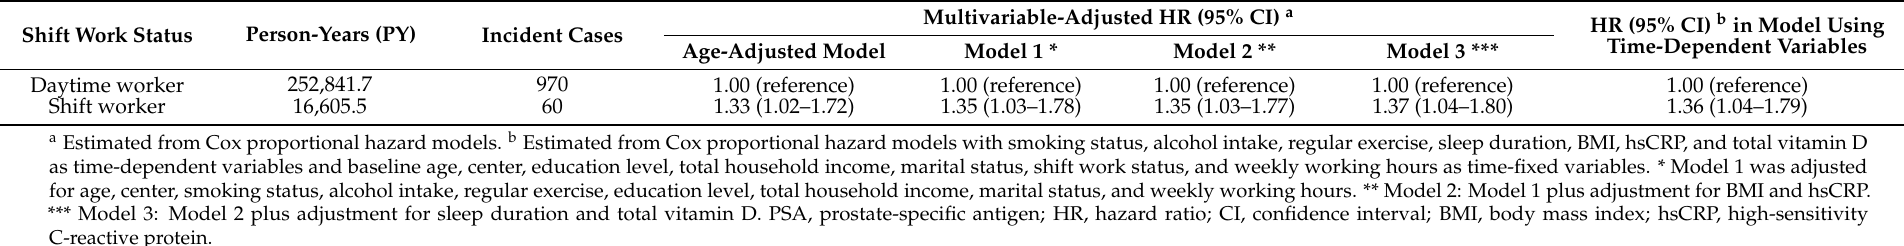
Table 2. Risk of elevated PSA according to shift work status.